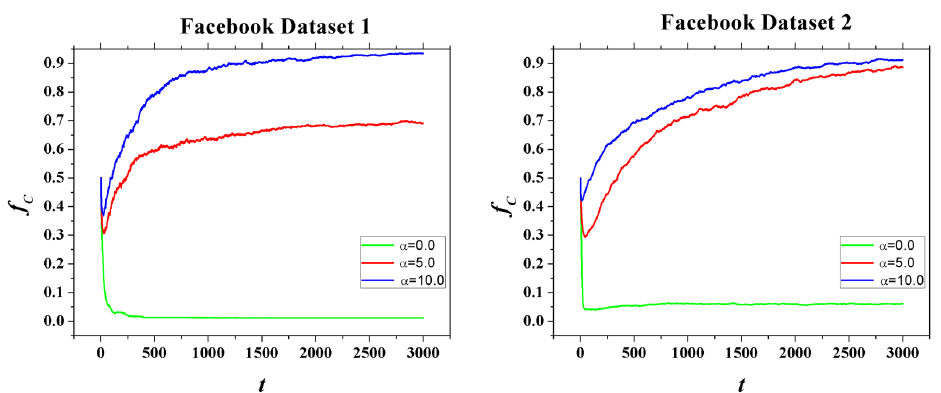
Figure 4. The effect of investment preferences a on the evolution of cooperation. t denotes time steps. We set b ~ 20 and c ~ 1 here. The results show that cooperation is prohibited if the investment preference is weak ( a ~ 0 ). Extremely strong a leads to global